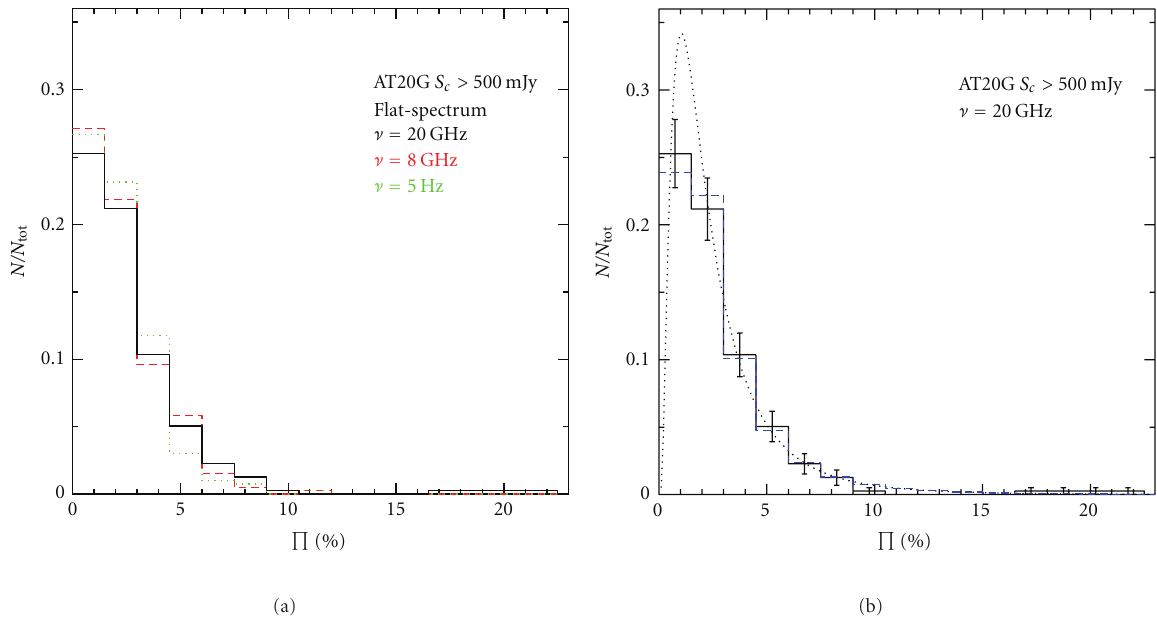
Figure 2: (a) Distribution of the fractional polarization at 4.8, 8.6, and 20 GHz (green dotted, red dashed, and black solid histograms, resp.) for flat-spectrum sources with S ≥ 500mJy in the almost-complete subsample of the AT20G survey. (b) Distribution of the fractional polarization at 20 GHz (black solid histogram) compared to the distribution (blue dashed histogram) produced by a log-normal distribution (see also Section 5.1) with Π med = 2 . 01 and (cid:9) Π 2 (cid:10) = 3 . 84 (black dotted line; see Table 2) at 20GHz.